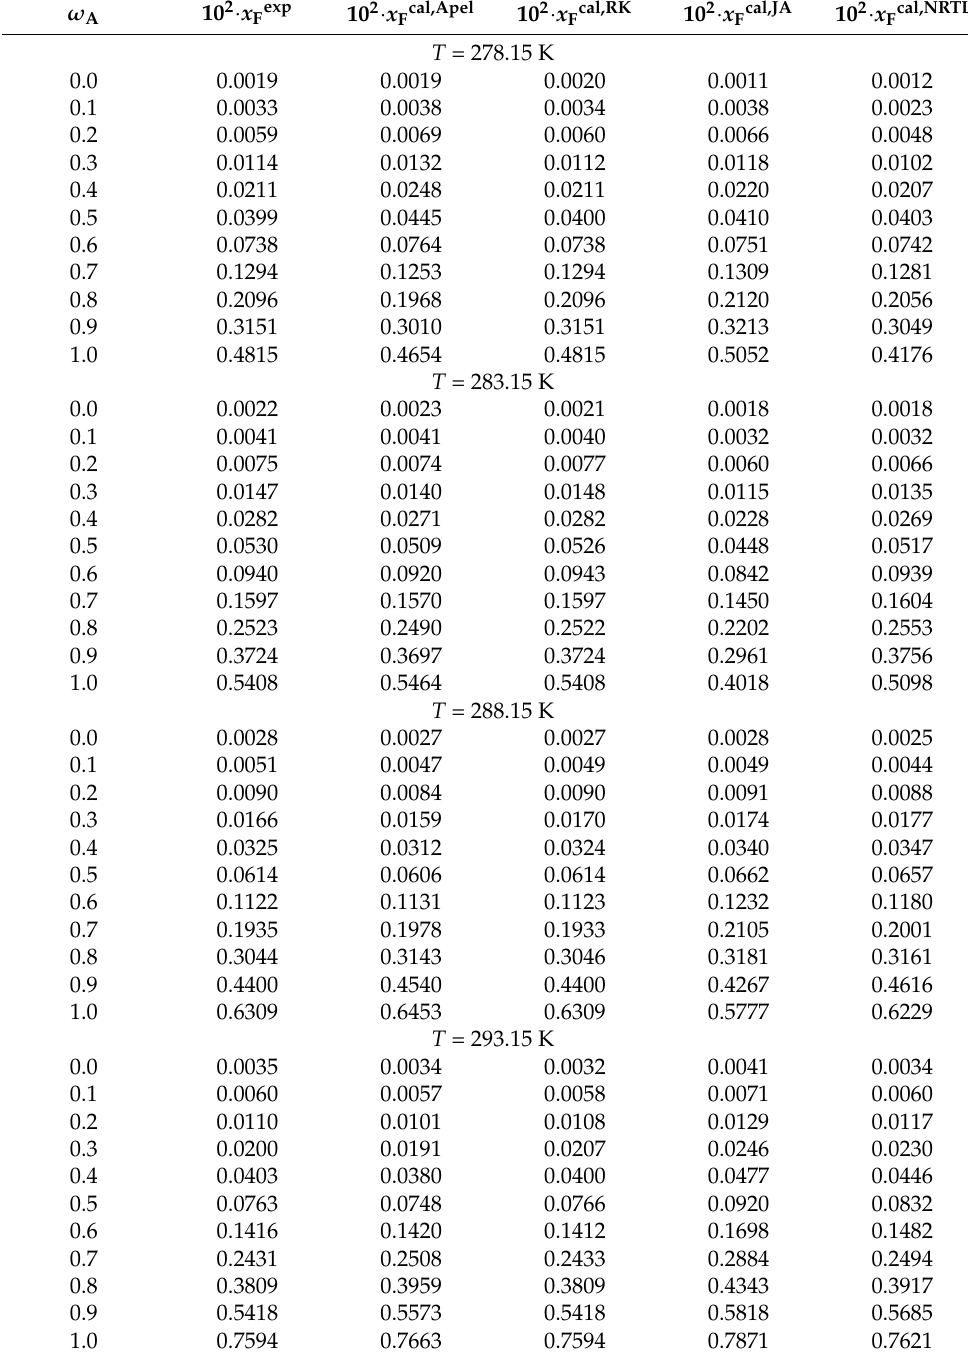
Table 1. Experimental and calculated molar ratio solubility of florfenicol in binary solvent mixtures of methanol + water from T = 278.15 to 318.15